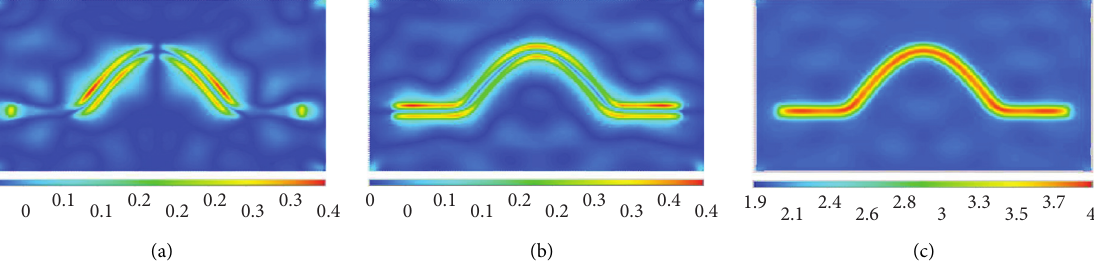
Figure 52: P wave incident (NR � 1, f � 2.0Hz, H � 100m, and C